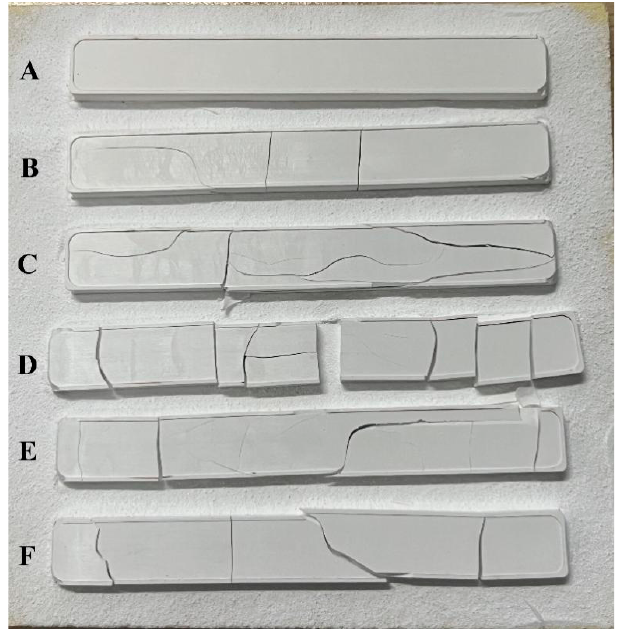
Figure 6. Photographs of green parts (samples A–F) after thermal debinding. Though the green parts of samples B–F were broken after thermal debinding, they were sintered at 1575 °C for 2 h with sample A for density and hardness measurements. As shown in Figure 7, the densities and hardness were between 6.00 and 6.03 g/cm 3 and 11.5–12.5 GPa, respectively. All the green parts could be densified with no significant difference in density and hardness.